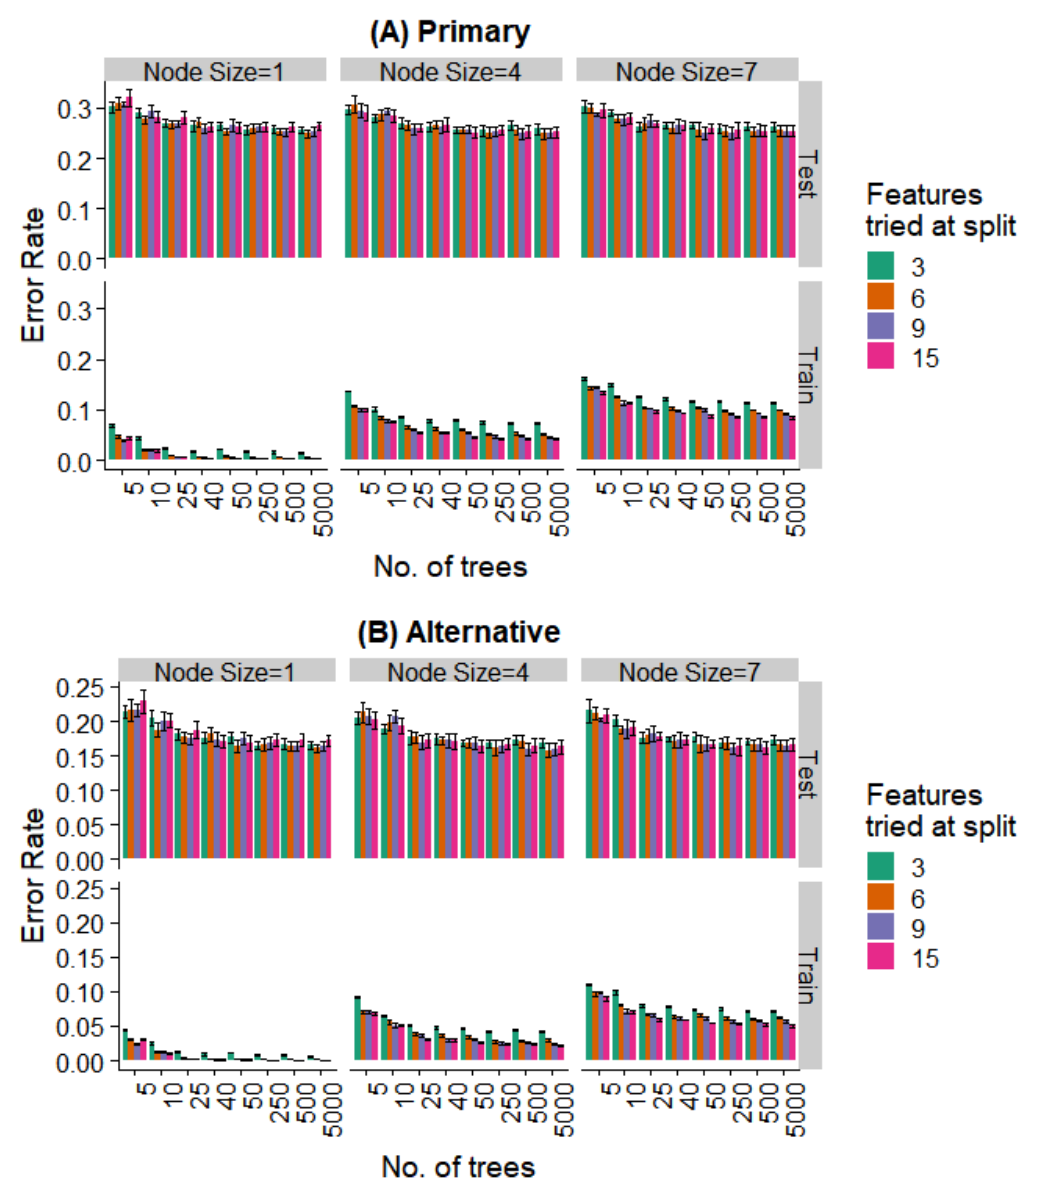
Figure 8. Effect of various training parameters on the random forest model for the prediction of the specific extraction. The minimum node size, features tried at every level of split, and the number of trees are varied and the error rates for the training and test split are plotted. In ( A ), a prediction is considered as an error if it does not agree with the expert’s primary diagnosis, and in ( B ), it is considered an error if the prediction does not agree with the primary or alternative diagnosis.